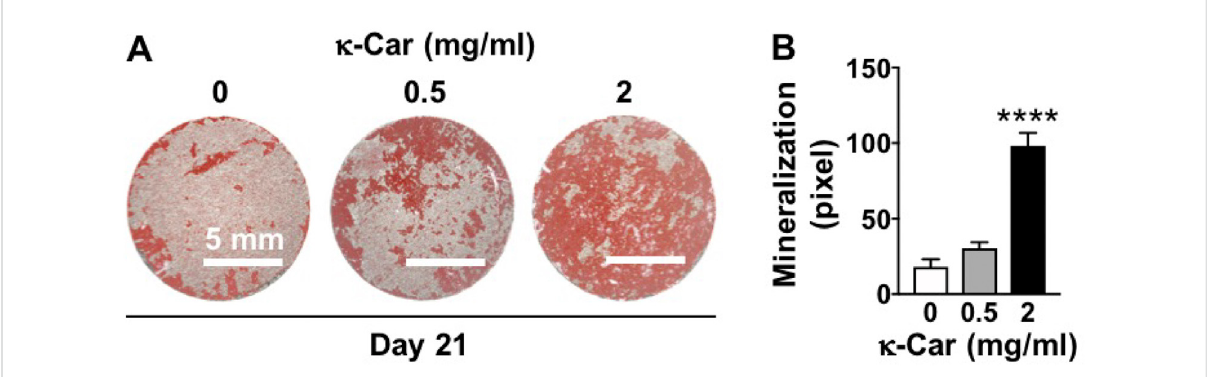
FIGURE 8 Dose-dependent effect of κ -carrageenan inOCP-coating oftitanium discs on extracellular matrixmineralization inMC3T3-E1 pre-osteoblasts at day 21. (A) Alizarin red-stained mineralized matrix. (B) Quantitive colorimetric results of extracellular matrix mineralization. Values are mean ± SD. n = 3 from 3 independent experiments. Signi fi cant effect of κ -carrageenan, **** p < 0.0001. κ -Car, κ -carrageenan. Bar: 5